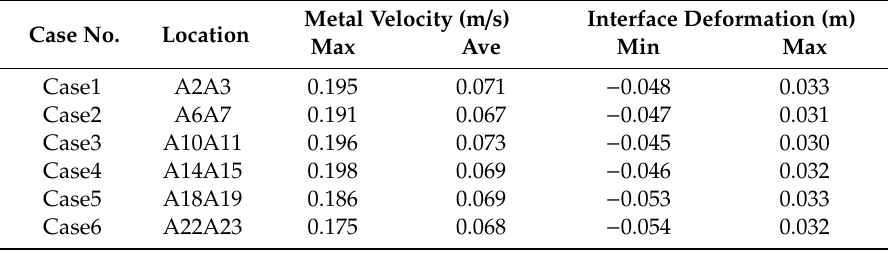
Table 2. Comparison of two-phase flow field simulation for six abnormal cases of LCEC. Case